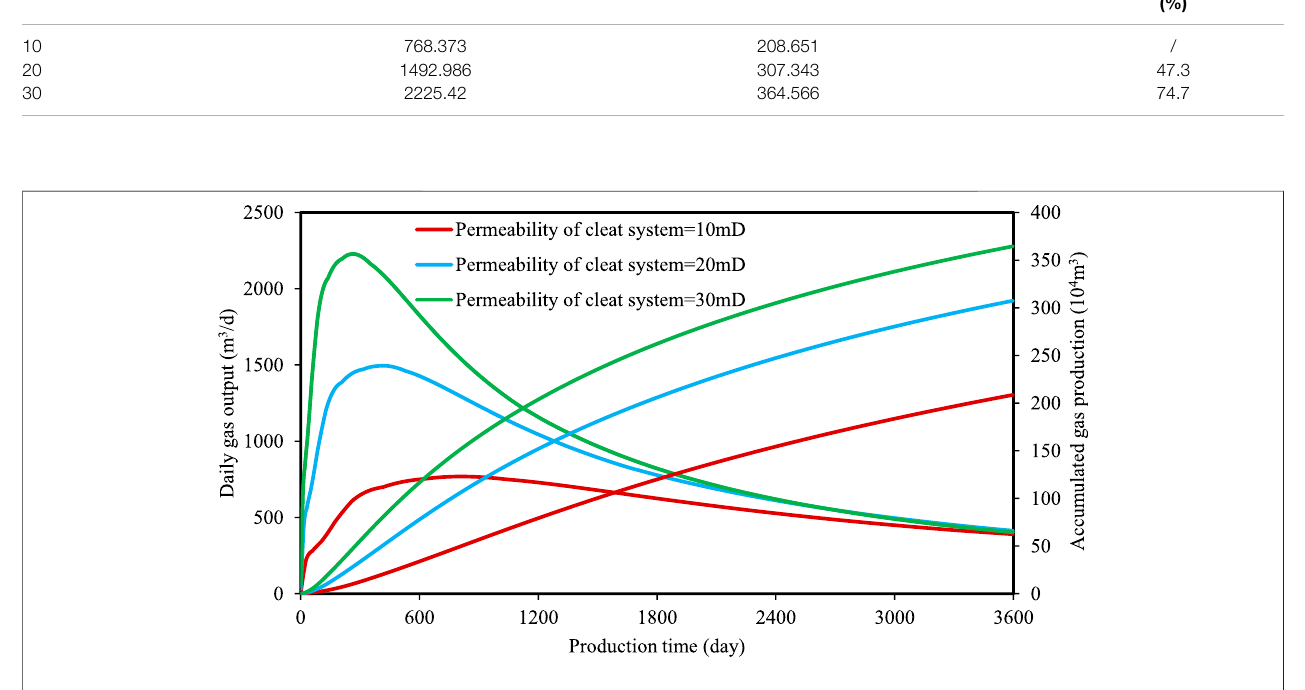
TABLE 3 | Effect of the permeability of the coal seam cleat system on CBM production. Permeability of the cleat system (mD)